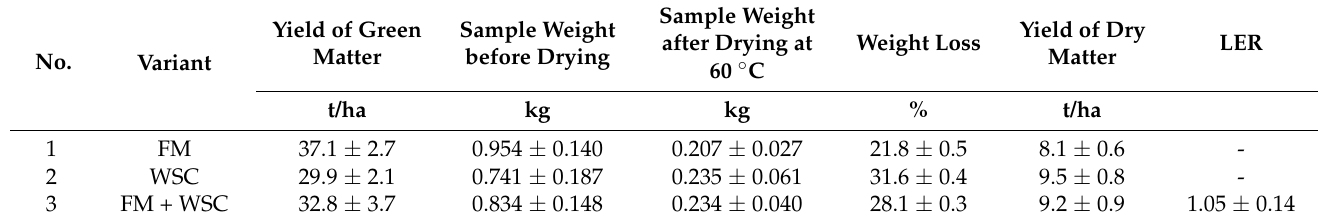
Table 3. Yield parameters of two monocultures and one mixed culture of FM and WSC. Troub- sko, 2019.